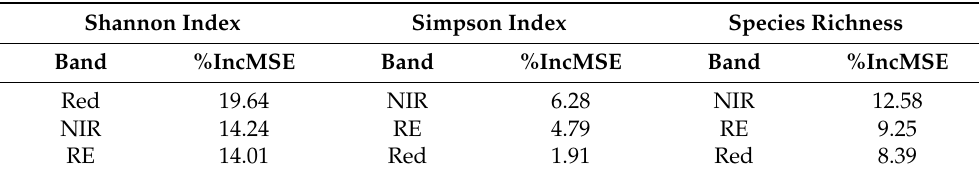
Table 6. Variable importance ranking for the RapidEye image model under the Shannon Index, Simpson Index and the Species richness.